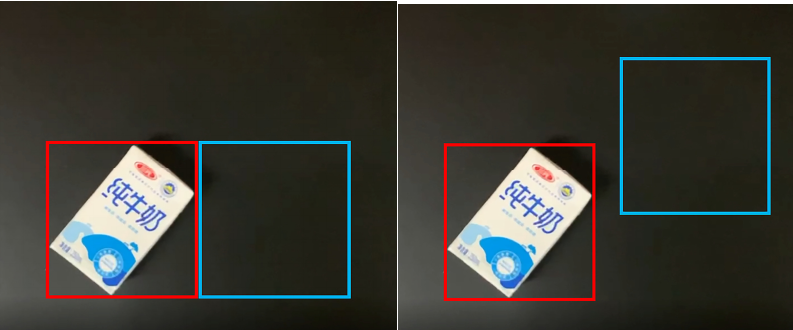
Figure 7. The case of IoU =